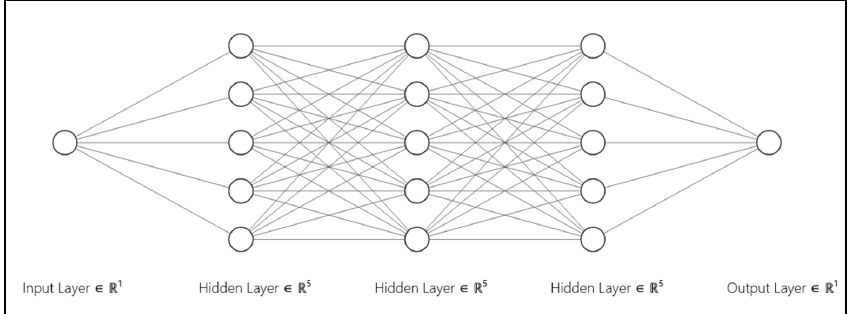
Figure 3. A neural network.